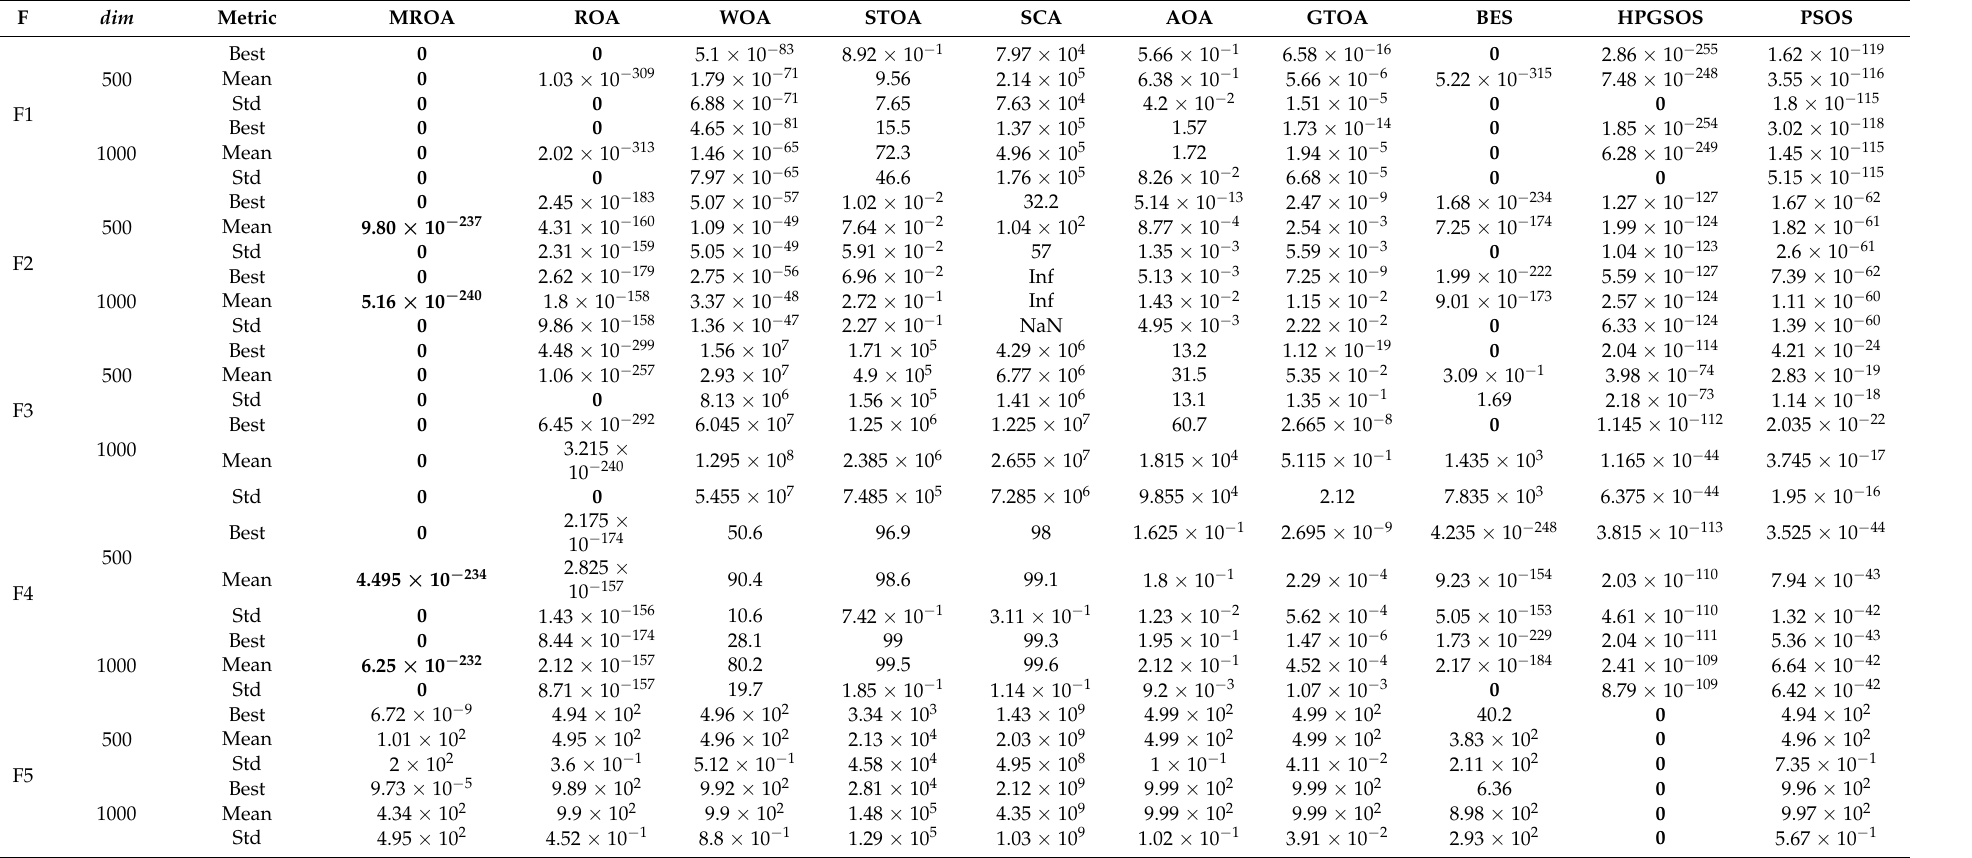
Table 4. Results of the MROA and other metaheuristic algorithms on test functions (F1–F13) in high dimensions (run 30 times). (Bold means good